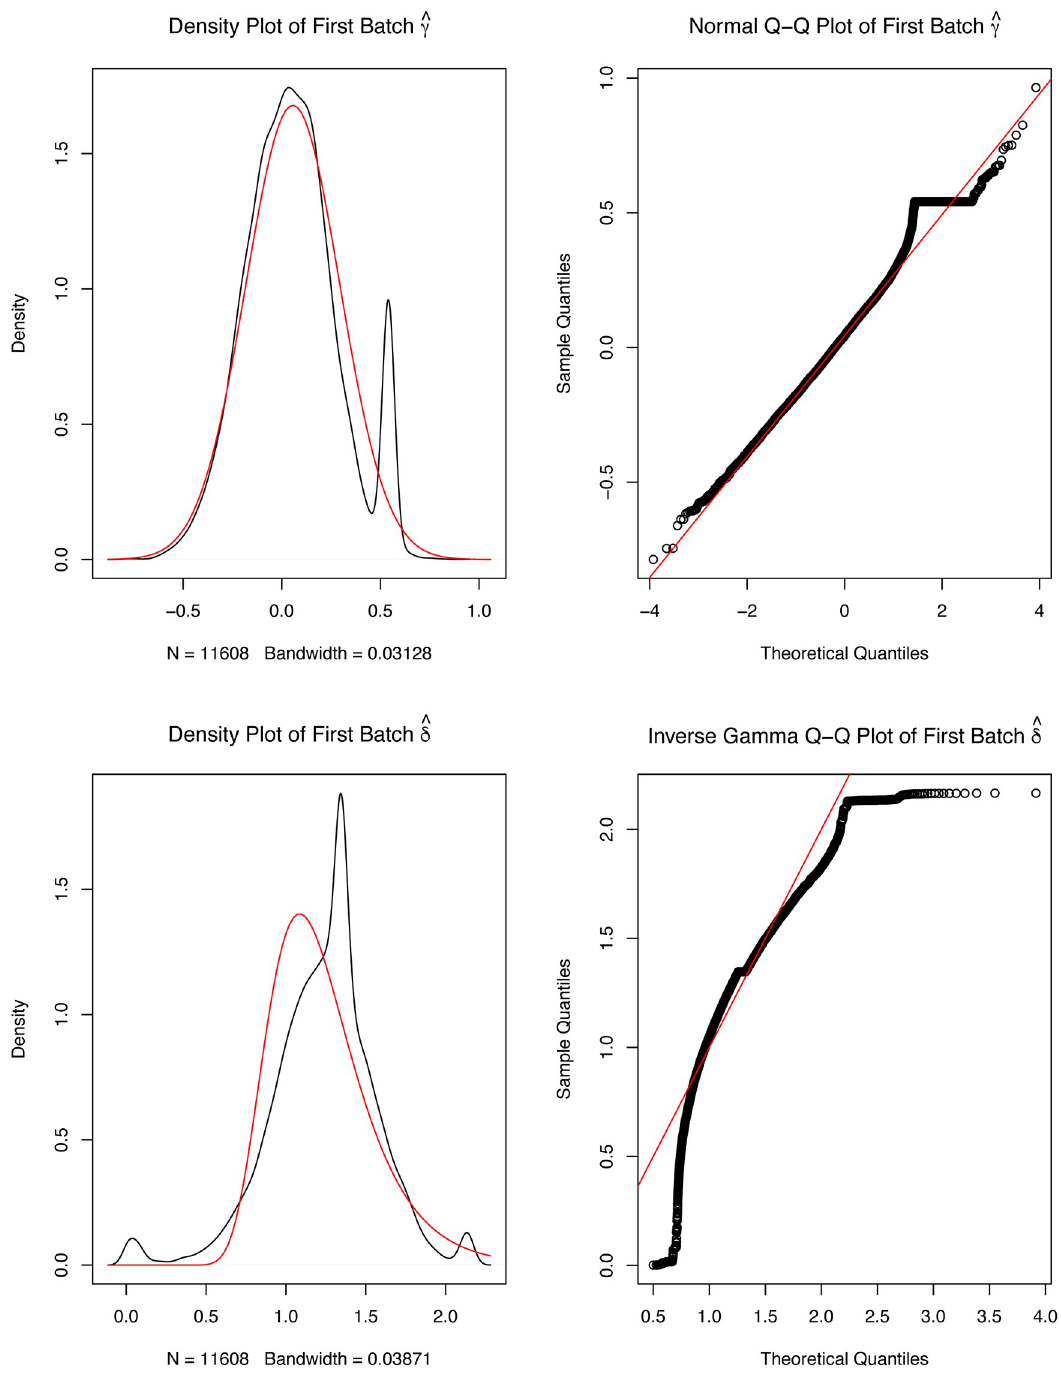
Fig 1. Example of the exploration of batch effects. Four plots generated by ComBat to correct for batch effects. For the left panel plots, the red lines are the parametric estimates, and the black lines are the kernel estimates for the distribution of effects across genes. The right panel shows Q-Q plots with the red line for the parametric estimate and the ordered batch effects for each gene (black points). The bottom plots show the analyses for the variances and the top plots refers to the means. Plots were generated for batches TSS E9 and E2 to avoid batches containing only one